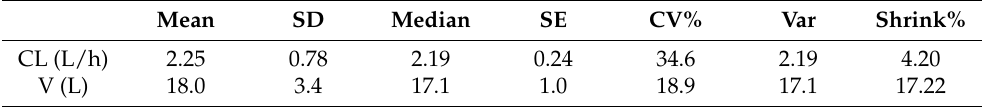
Table 2. Final estimates of population pharmacokinetic parameters for